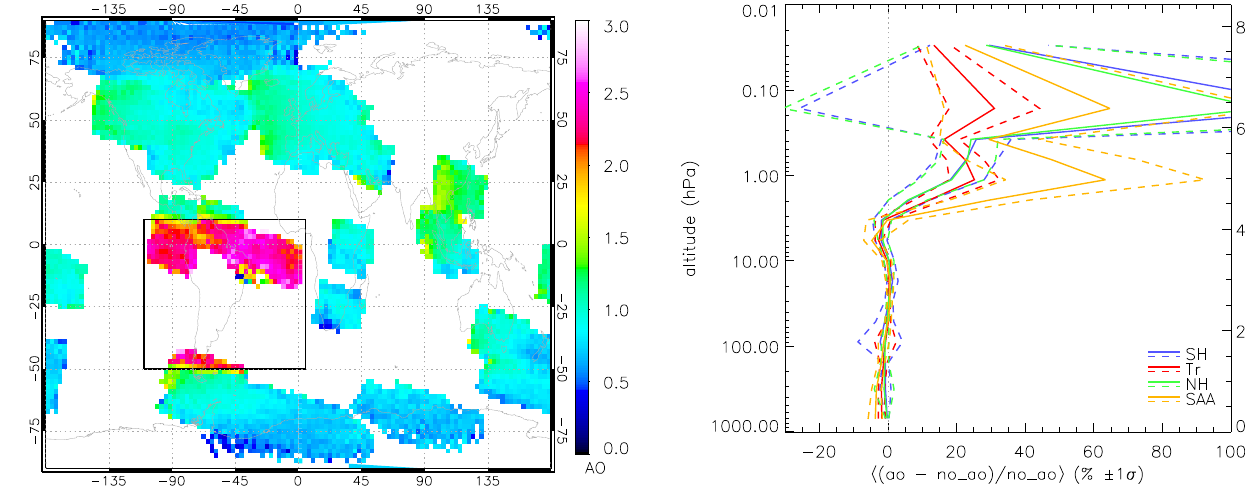
Fig. 14. The mean of the relative differences between the retrieval with additive offset (AO) and without (no_AO). The blue line gives the result for the Southern Hemisphere (SH), red for the tropics (Tr) and green for the Northern Hemisphere (NH) (solid for the mean, dashed for the ± 1 σ error). The South Atlantic Anomaly re- gion (SAA; see Fig. 12) has been treated separately and is plotted in orange.